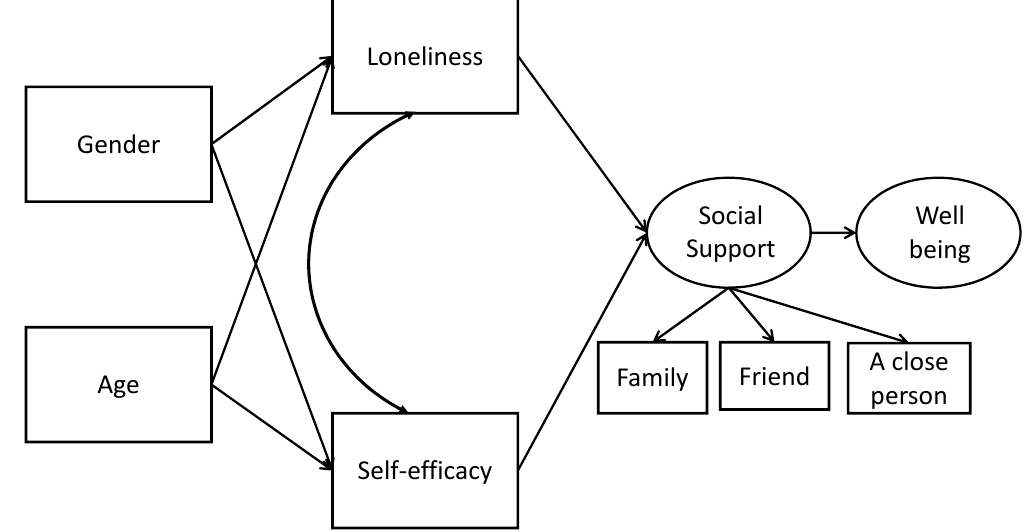
Figure 1. The conceptual hypothesis-testing model within a structural equation. Note: rectangles for observed variables, and ellipses for latent